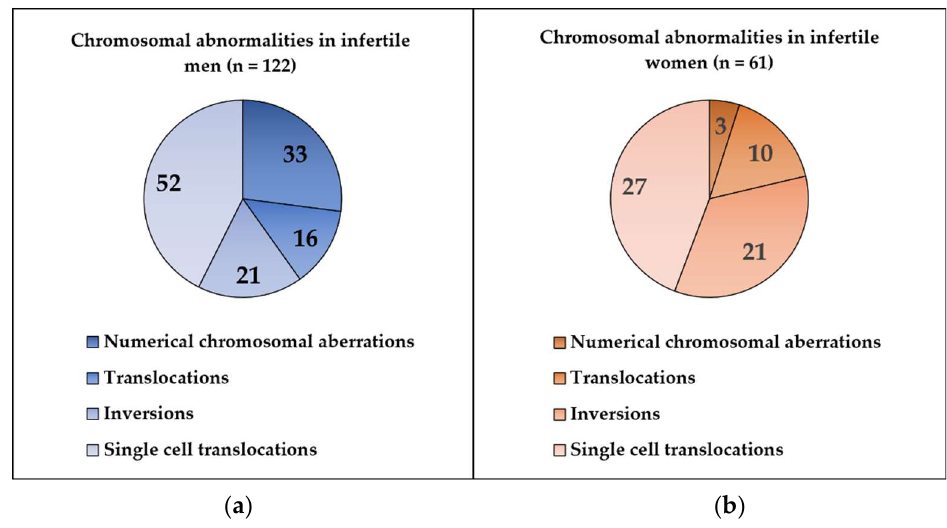
Figure 2. ( a ) Type of the chromosomal abnormalities in infertile men; ( b ) type of chromosomal abnormalities in infertile women.